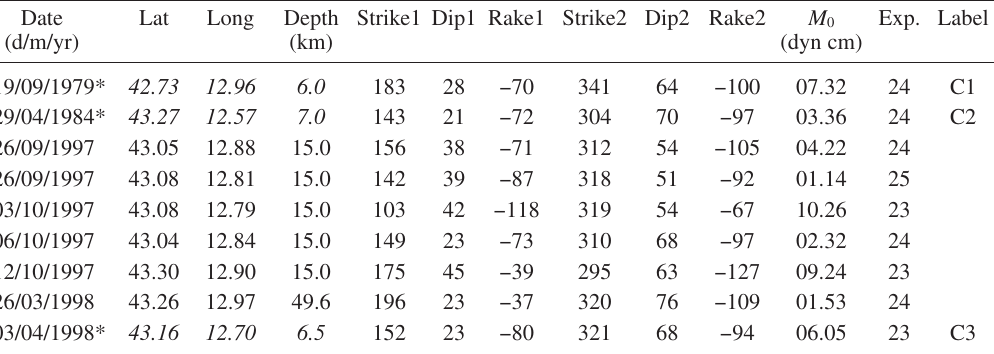
Table I. CMT Catalog. Parameters (strike, dip, and rake of the first and second nodal planes) of moment ten- sors selected for the study area from the Harvard CMT Catalog (Dziewonski et al. , 2001). The label C represents CMT, as described in the text. Events with * represent hypocentral locations sourced from: C1 – Deschamps et al. (1984); C2 – Collettini et al. (2003); C3 – Ciaccio et al. (2005); R1, R2, R4 and R5 – Chiaraluce et al. (2003); R7 and RN1 – Castello et al. (2005); R3 and D2 – present study; F10 – Di Luccio et al.